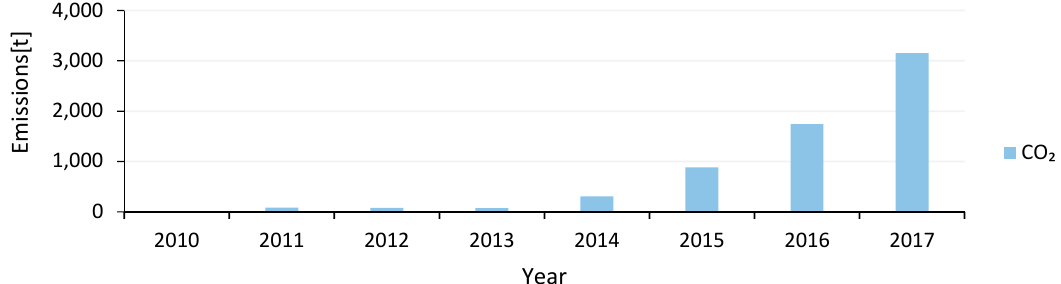
Figure 5. Reduction of CO and NO x emissions thanks to the replacement combustion with electric cars in Poland in 2010–2017.